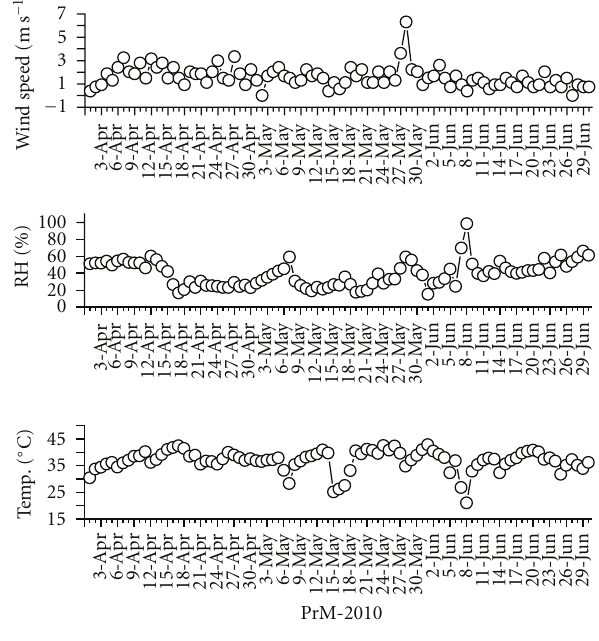
Figure 2: Day-to-day variation of the meteorological parameters (maximum temperature, relative humidity, wind speed) over Patiala during pre-monsoon season (April–June) of 2010.